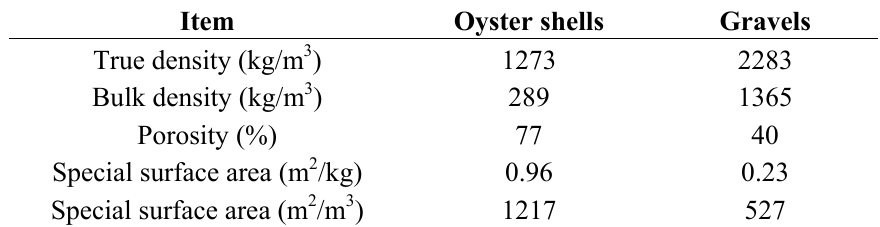
Table 1. Summary of physical properties of oyster shells and gravels [9].